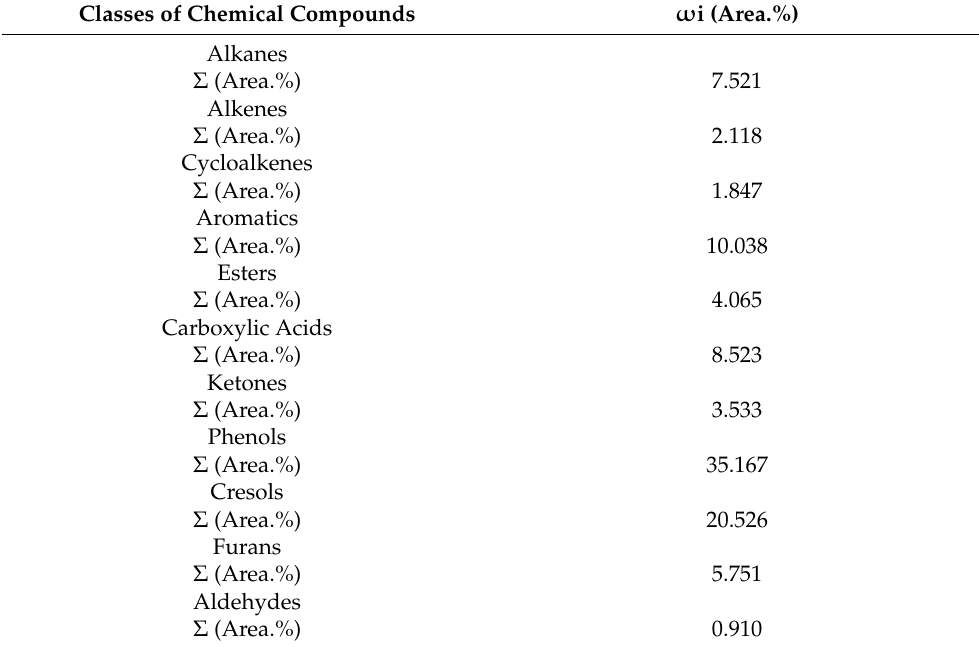
Table 8. Classes of compounds and summation of peak areas of hydrocarbons and oxygenates identified by CG-MS in bio-oil obtained in pilot scale.